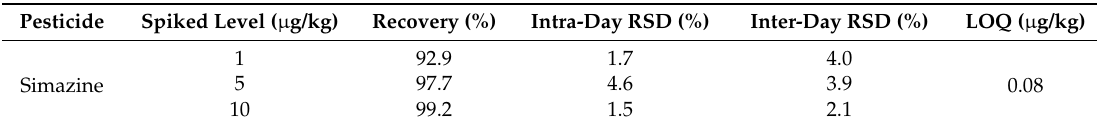
Table 1. Relative recovery (%), intra-day RSD (%) and inter-day RSD (%) obtained for simazine in soil by UPLC-MS/MS.